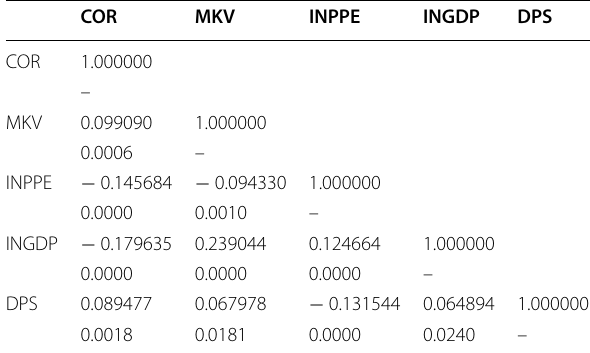
Table 2 Correlation matrix of data series. Source :